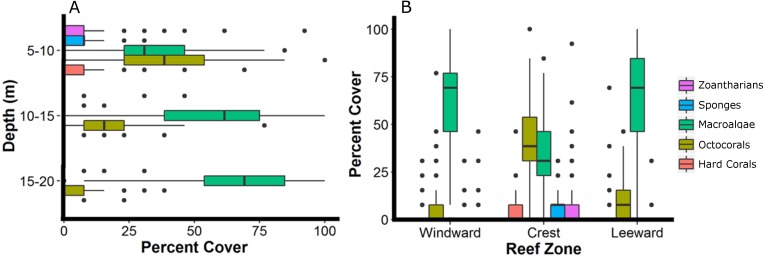
Relative abundance of the main groups of sessile organisms at different depth intervals (A) and zones (B) of Madagascar reef, Gulf of Mexico.Box-plots represent four quartiles and median, with outliers as points.